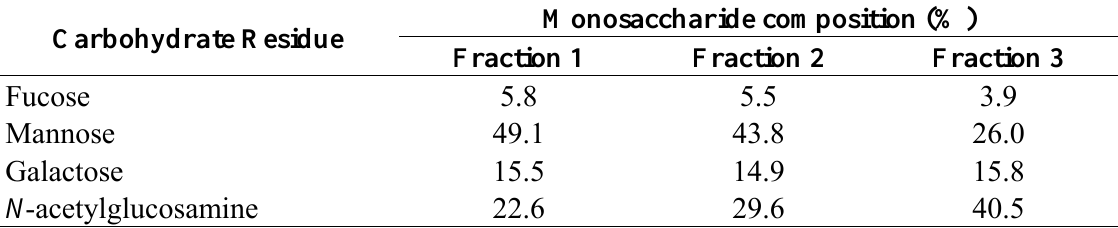
Table 8. Carbohydrate compositions of the glycopeptide pools separated by affinity chromatography in an immobilized PAA column (Figure